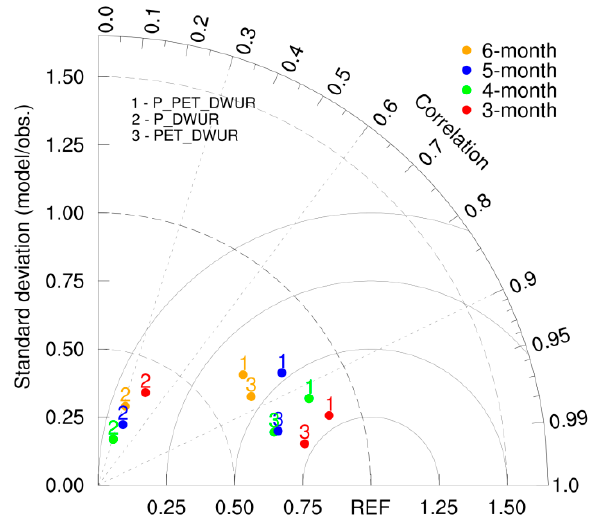
Figure 8. Performance of simulated water-use rate WUR statistics in the validation period over Yeongsan River basin.